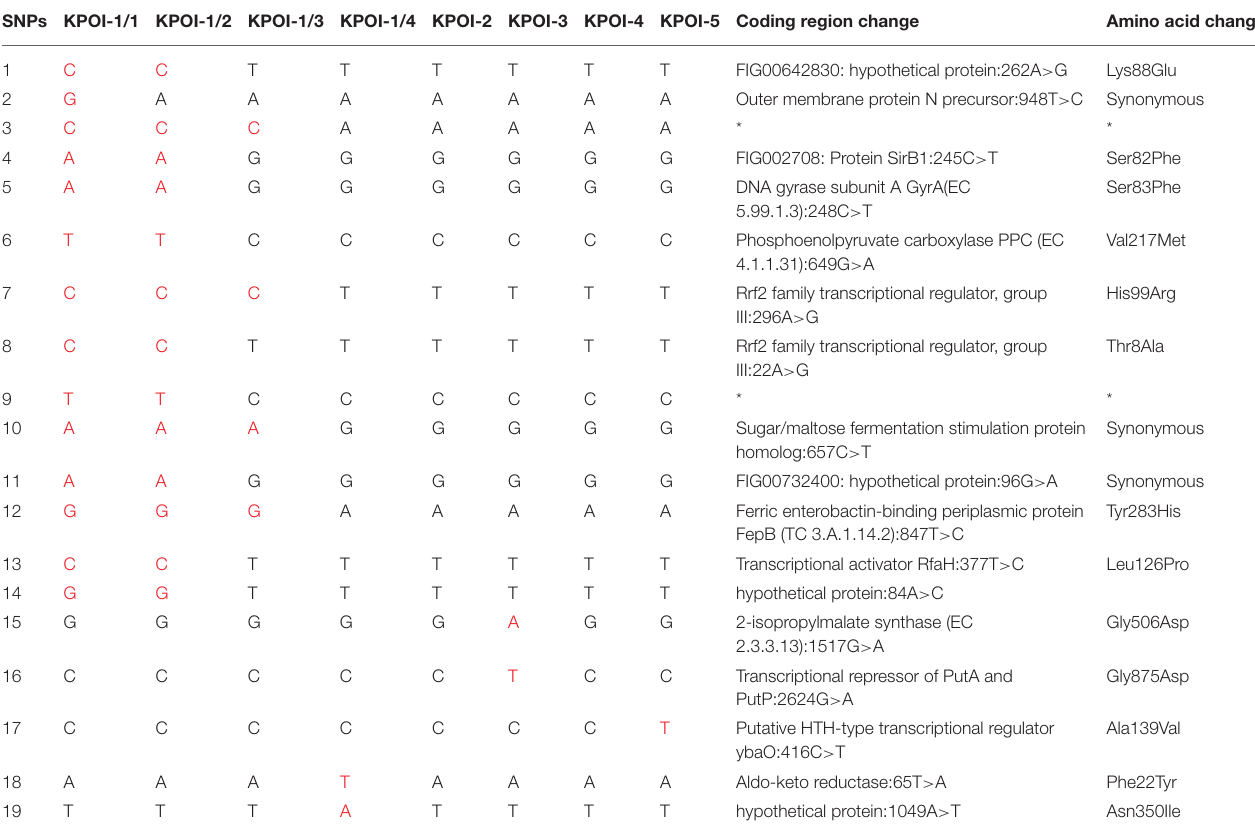
SNPs are highlighted in red. * SNPs located in intergenic